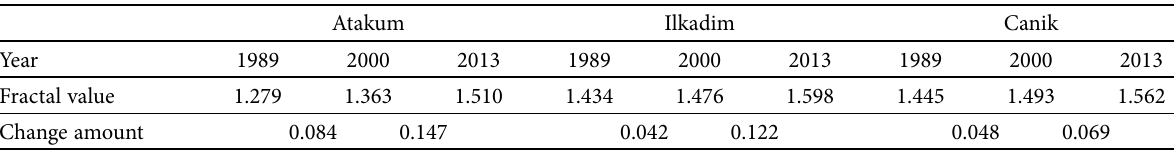
Fig. 5. Overlapping of layers with different box sizes for Canik Table 4. Fractal